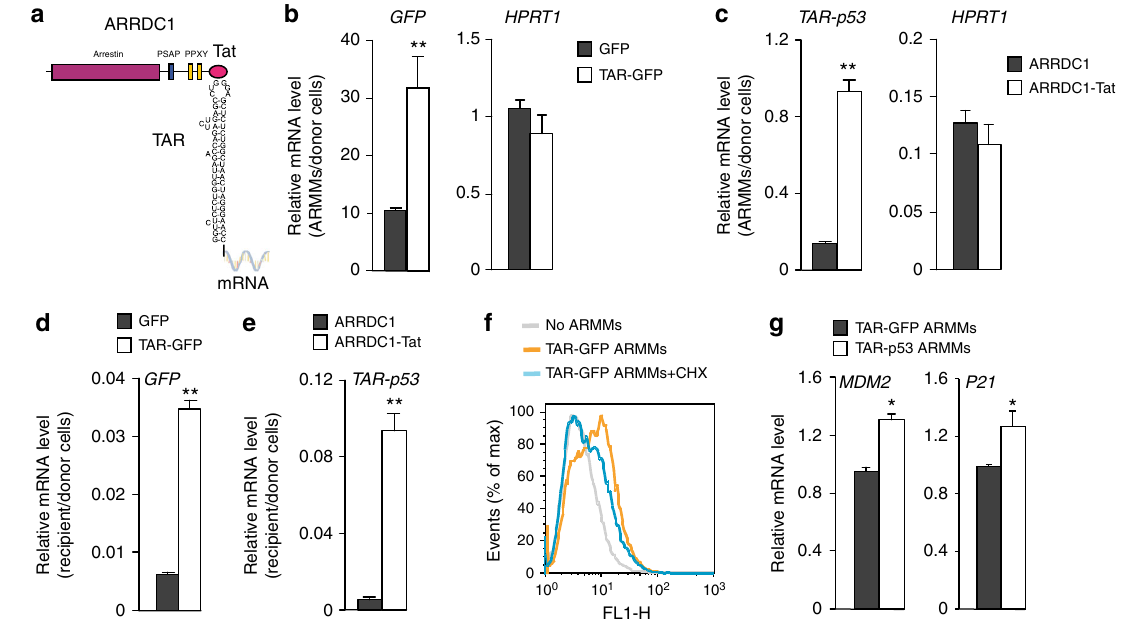
Fig. 2 Packaging and delivery of RNAs via ARMMs. a RNA packaging strategy. TAT peptide, which binds speci fi cally to TAR, is fused to the C-terminus of ARRDC1 to recruit RNA cargo molecules linked to TAR, into ARMMs. b Packaging of TAR-GFP mRNA in ARMMs. ARRDC1-TAT was co-transfected with TAR-GFP or control GFP construct into HEK293T cells. ARMMs were pelleted via ultracentrifugation. qRT-PCR was done on ARMMs and on the transfected cells for GFP and for a control mRNA (HPRT1). c Packaging of TAR-p53 mRNA in ARMMs. TAR-p53 was co-transfected with ARRDC1 or ARRDC1-TAT construct into HEK293T cells. ARMMs were pelleted via ultracentrifugation. qRT-PCR was done on ARMMs and on the transfected cells for TAR-p53 and for HPRT1. d Transfer of TAR-GFP mRNA into recipient cells. A549 cells were incubated with ARMMs containing TAR-GFP mRNA overnight, washed with PBS extensively, and subjected to mRNA analysis by qRT-PCR. e Transfer of TAR-p53 mRNA into recipient cells. p53-null H1299 cells were incubated with ARMMs containing TAR-p53 mRNA overnight, washed with PBS extensively, and subjected to mRNA analysis by qRT-PCR. f Translation of ARMMs-delivered GFP mRNA in recipient cells. A549 cells were incubated with ARMMs containing TAR-GFP mRNA for 24 h with or without the translational inhibitor cycloheximide (CHX), and subjected to fl ow cytometry analysis. g Activation of p53 target genes in recipient cells receiving TAR-p53 ARMMs. P53-null H1299 cells were incubated with ARMMs containing TAR-p53 mRNA for 18 h and subjected to mRNA analysis by qRT-PCR to detect MDM2 and p21 mRNAs. At least three independent replicates were done for all assays. Data were presented as the mean ± SD in the bar graphs. * p < 0.05; ** p <